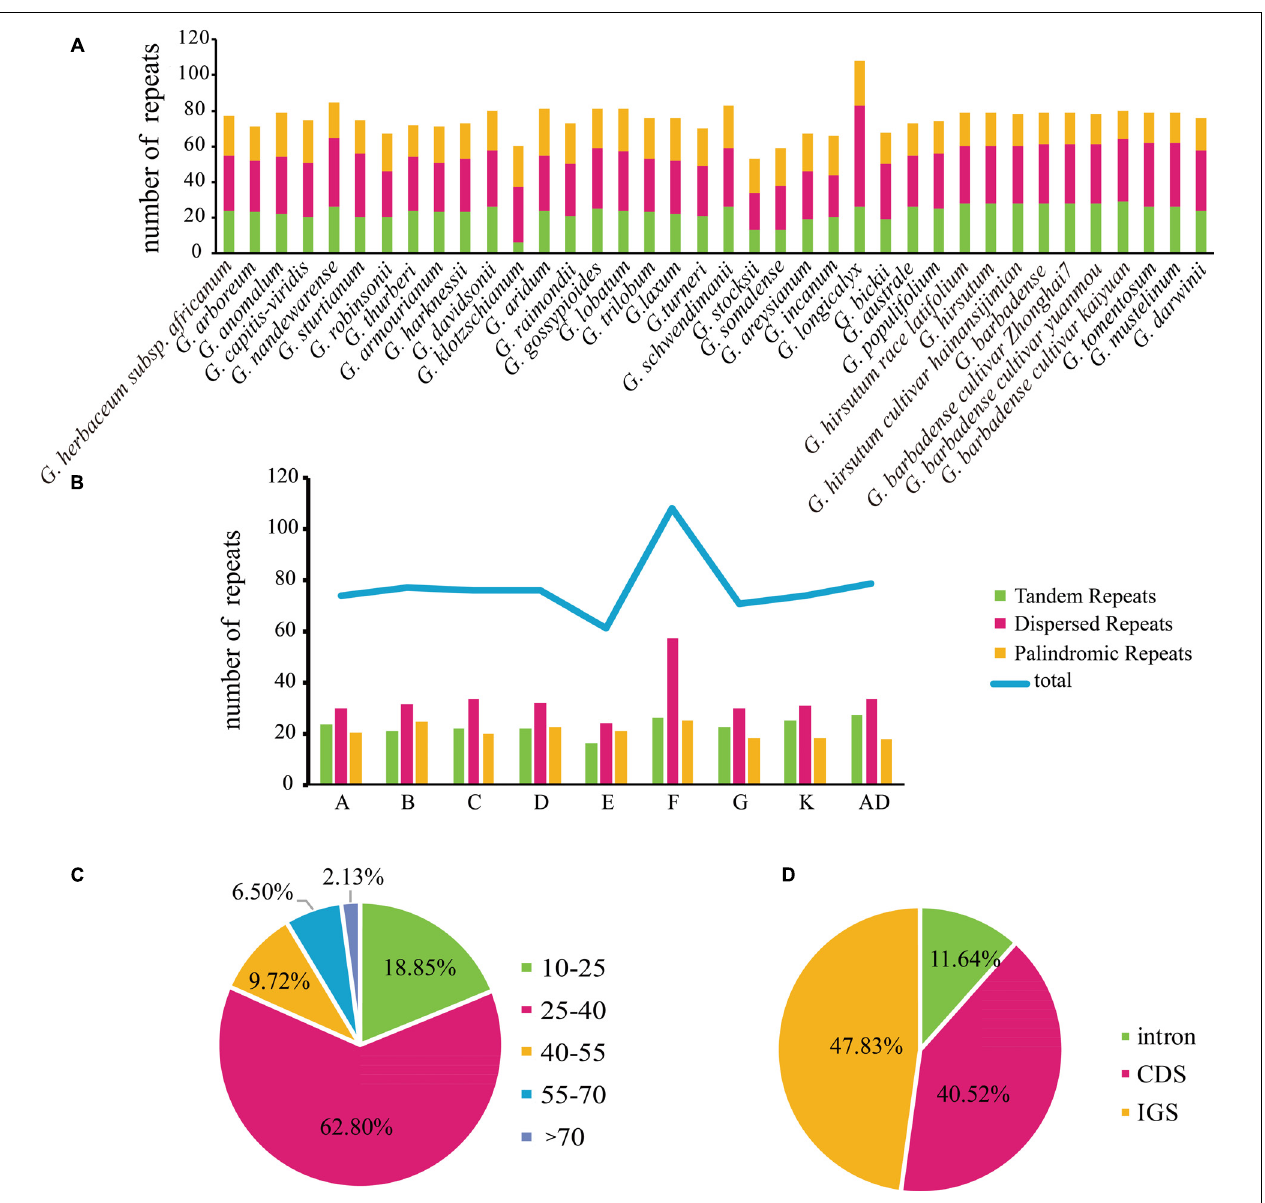
FIGURE 1 | Analysis of repeated sequences in cotton chloroplast genomes. (A) Numbers of three repeat types. (B) Average number in each genome. (C) Summary of repeat sequences by length. (D) Distribution of repeat sequences. ∗ Newly sequenced species in this